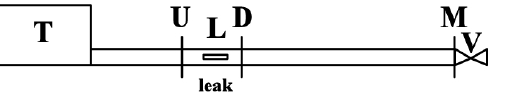
Figure 3. Device used to simulate leaks. 3